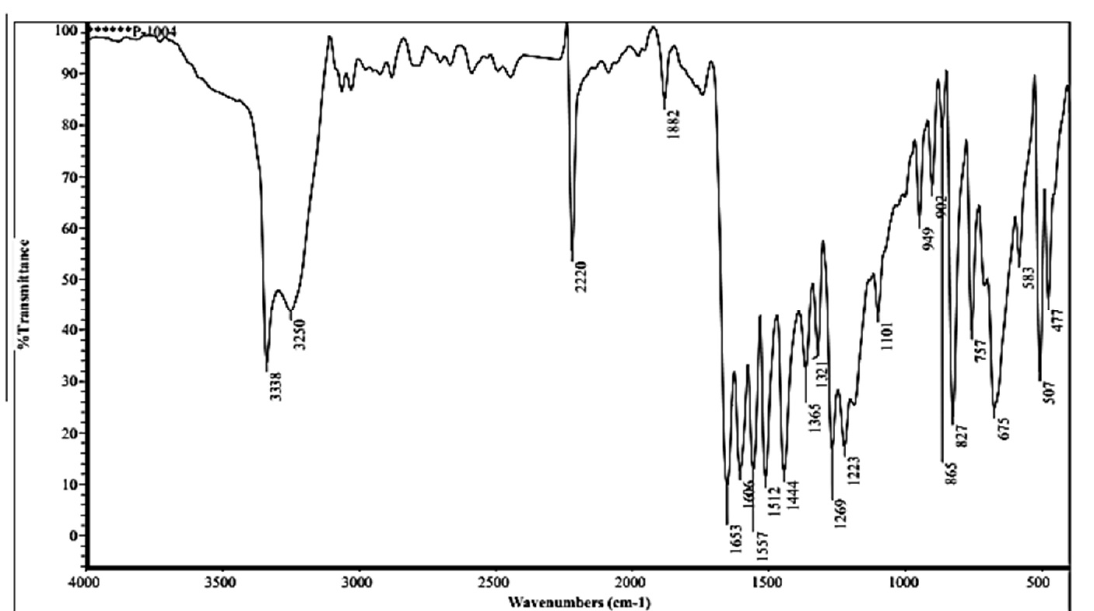
Figure 5. FTIR of